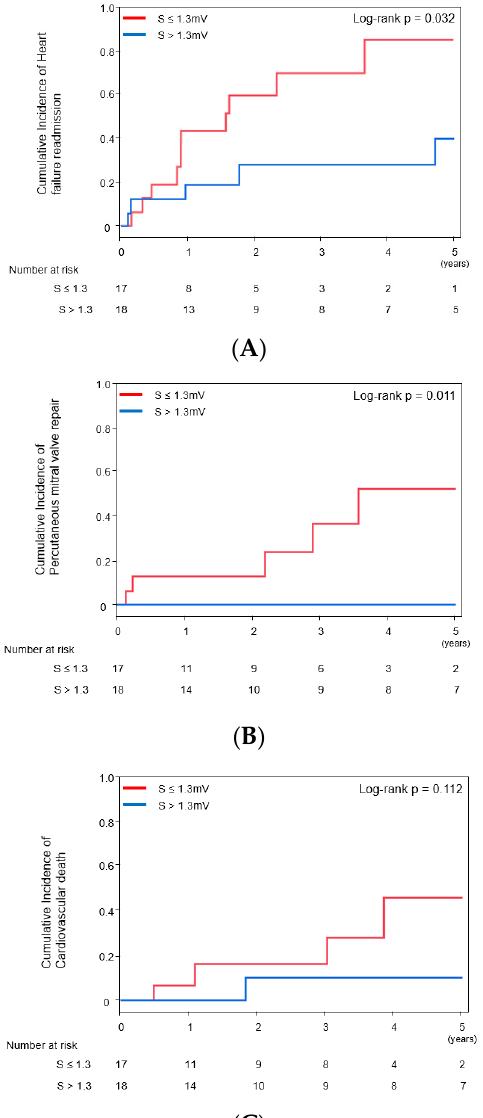
Figure 3. Cumulative incidence of clinical events stratified by the cutoff of S-wave amplitude (( A ) heart failure readmission; ( B ) percutaneous mitral valve repair; ( C ) cardiovascular death). Odds ratio of S > 1.3 mV for heart failure readmission was 0.31 [0.10–0.95], p = 0.040, and for cardiovascular death was 0.11 [0.01–0.95], p = 0.045.